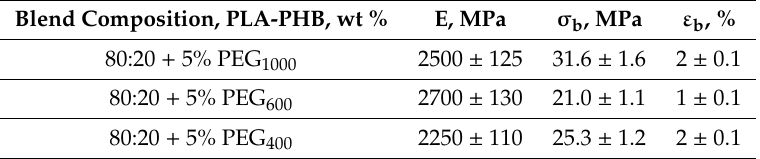
Table 2. Influence of PEG with di ff erent molar mass on mechanical properties of PLA-PHB blends.